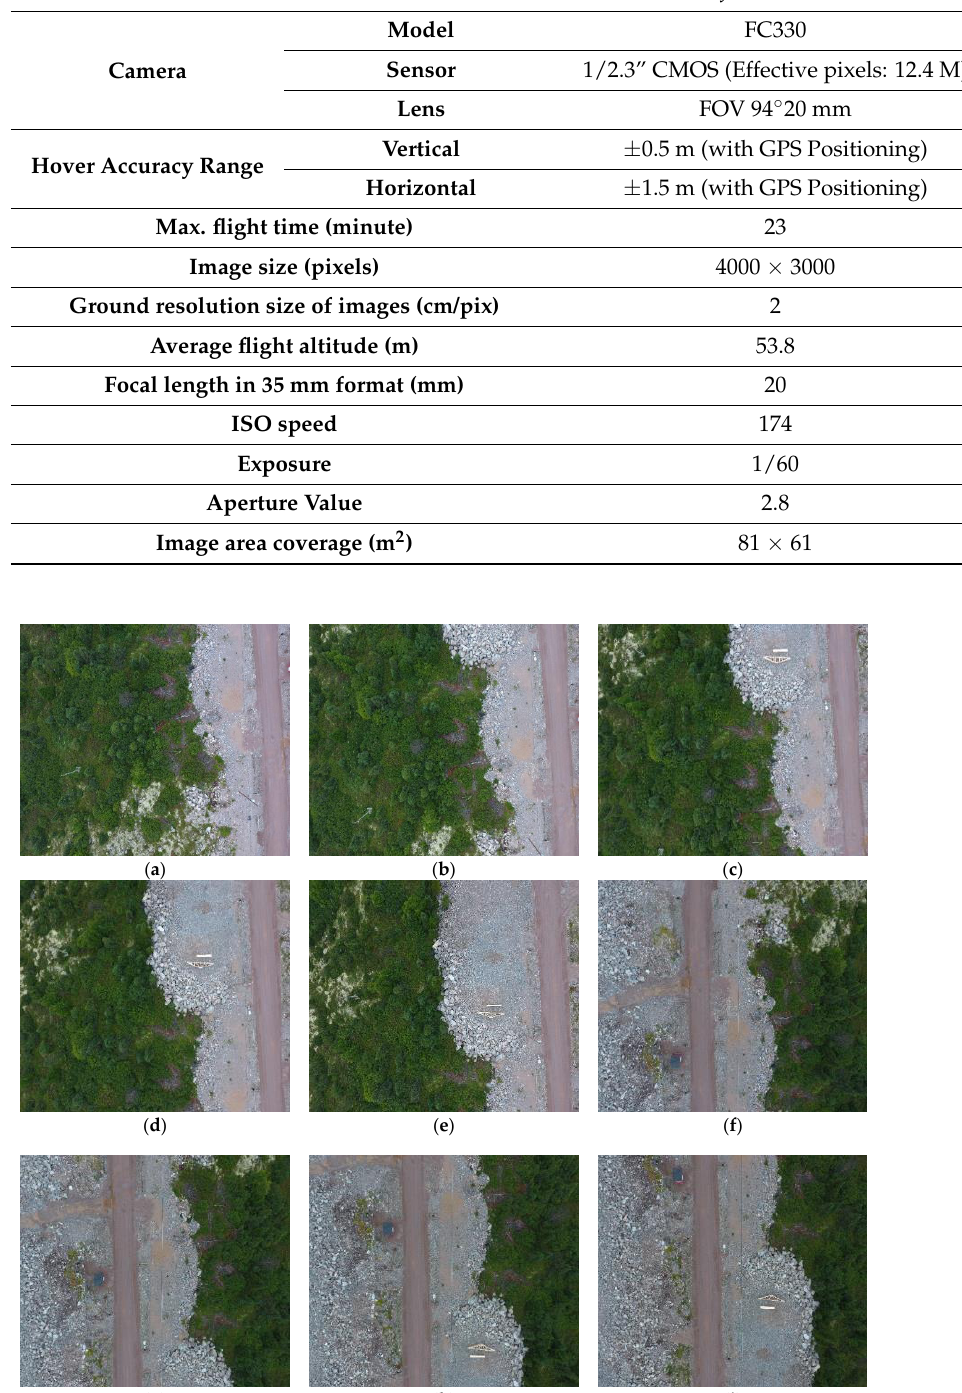
Table 2. The UAV image pair specifications.